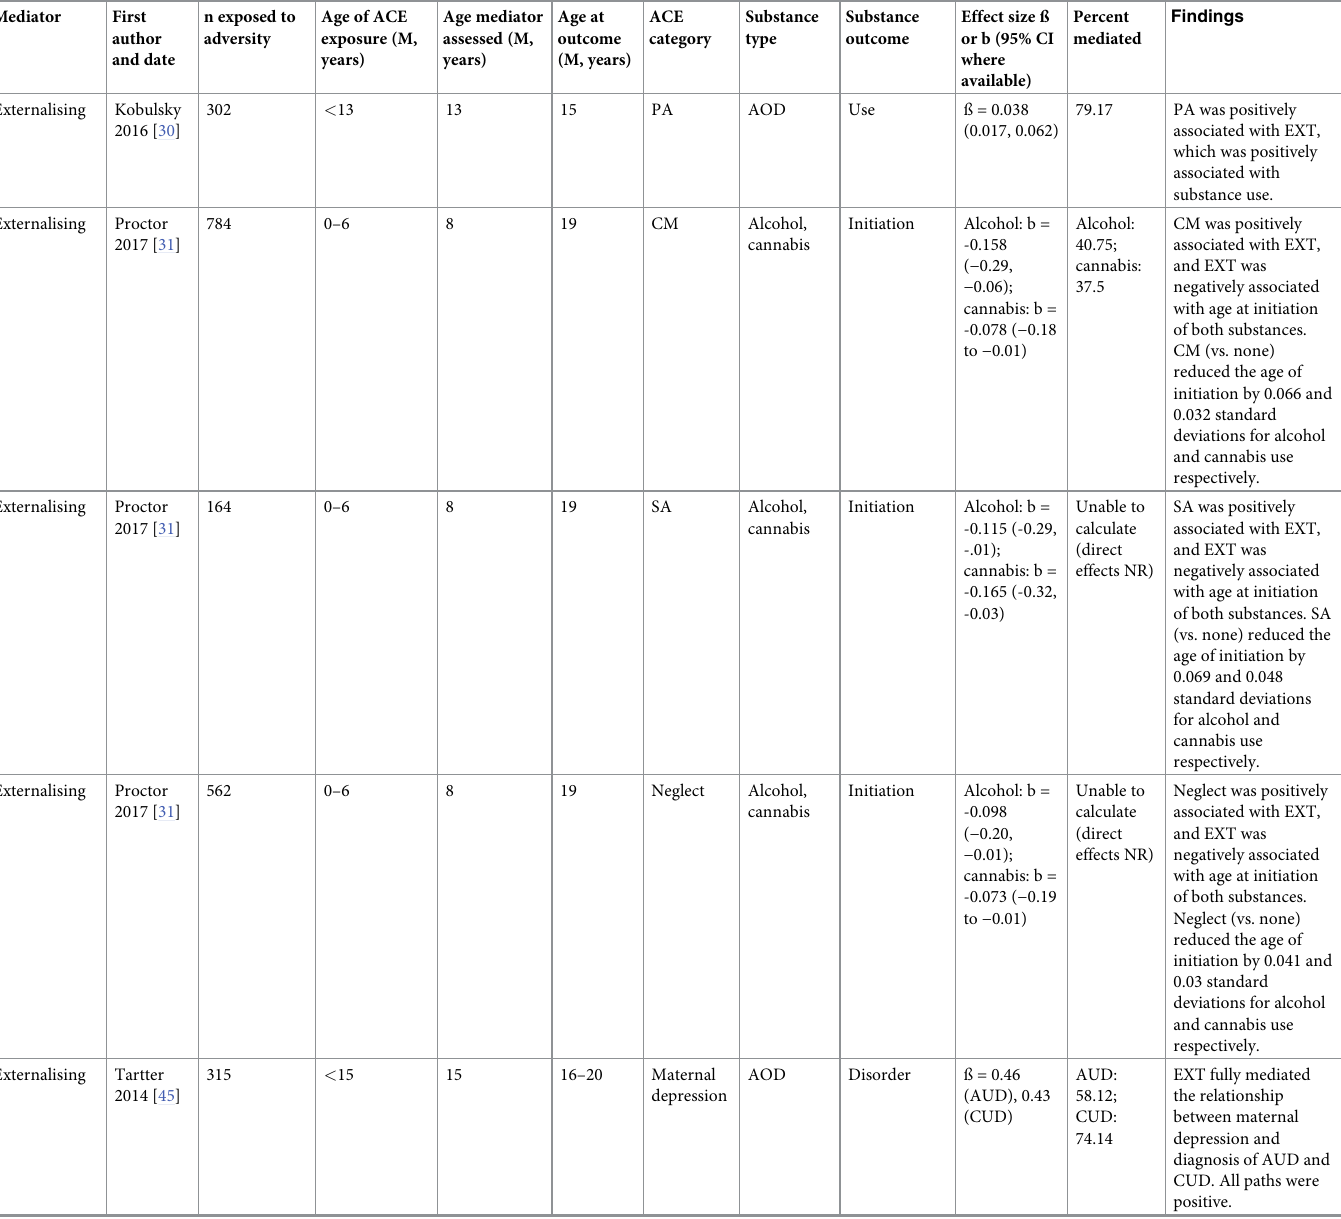
Table 2. Results of ten primary studies examining externalising behaviours as